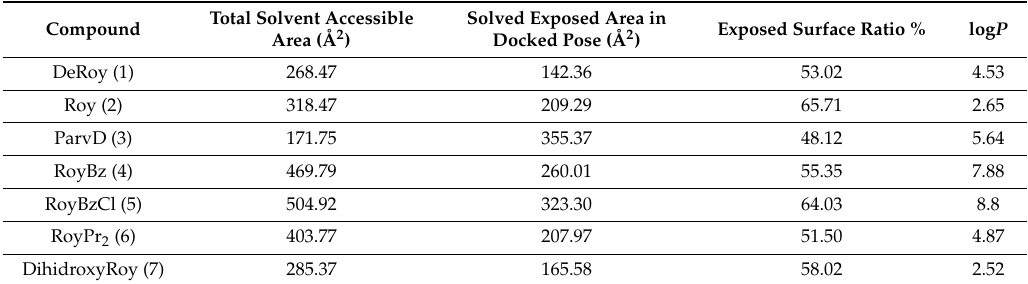
Table 5. Compound octanol / water partition (log P ) values and solvent-accessible surface area for docked poses in PKC α